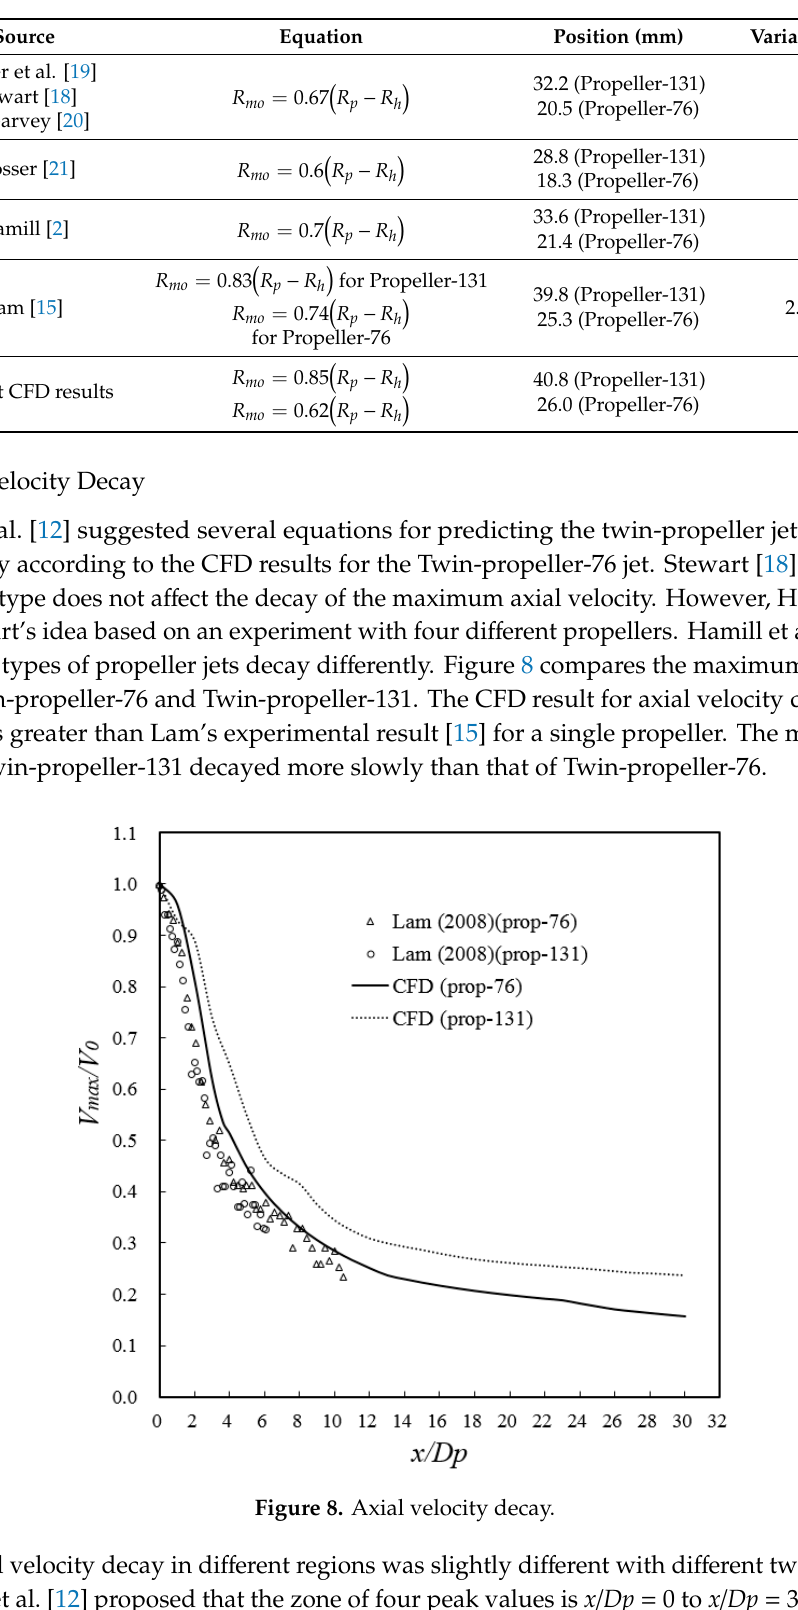
Table 4. Positions of maximum e ffl ux velocity.